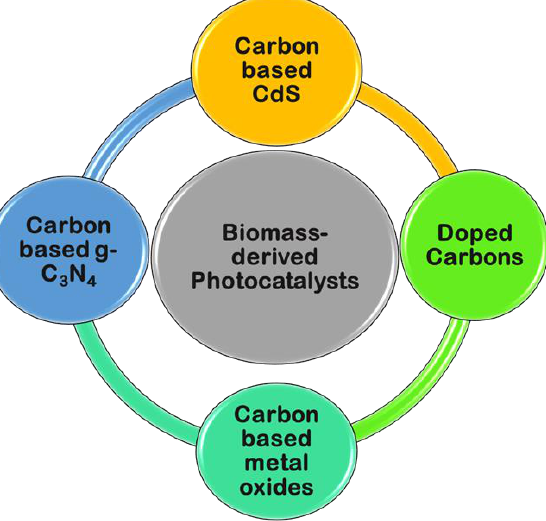
Figure 17. Biomass-derived carbons as photocatalytic materials.